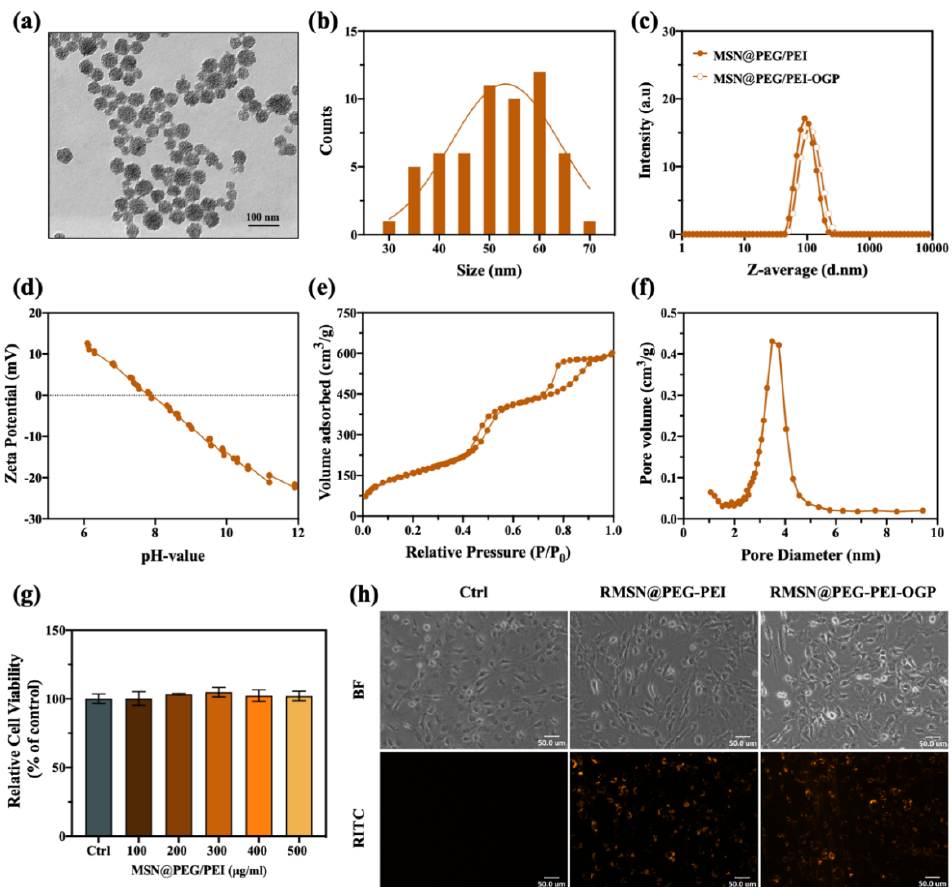
Figure 2. ( a ) TEM image and ( b ) particle size distributions of MSN@PEG/PEI. ( c ) DLS analyses of MSN@PEG/PEI and MSN@PEG/PEI − OGP in PBS. ( d ) Zeta potential measurements of MSN@PEG/PEI over pH ranging from 6 to 12. ( e ) Nitrogen adsorption-desorption isotherms and ( f ) pore size distribution of MSN@PEG/PEI. ( g ) Cell viability of MC3T3 − E1 treated with different con- centrations of MSN@PEG/PEI. ( h ) Fluorescence images of MC3T3 − E1 cells at 24 h post −